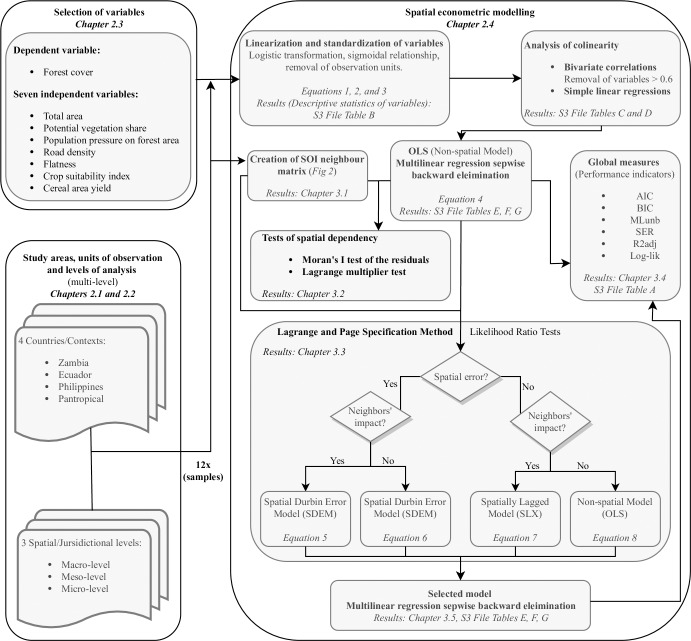
Conceptual diagram summarizing the analytical framework of this research article.